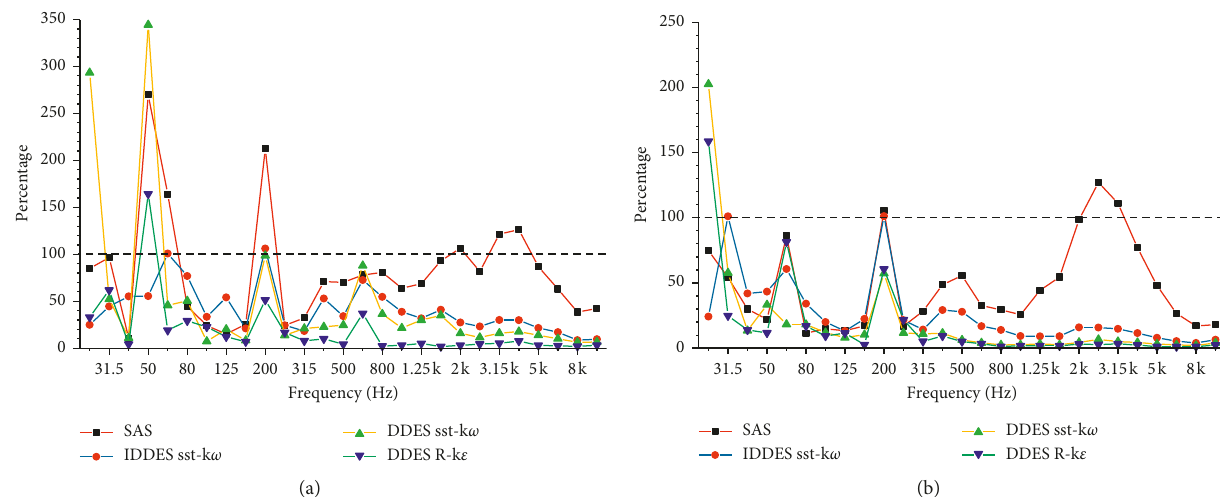
Figure 19: Percentage of equivalent radiated acoustic energy density of the four models relative to LES at all frequencies (350 km/h): (a) whole pantograph; (b) bottom frame area. The dashed line represents the LES